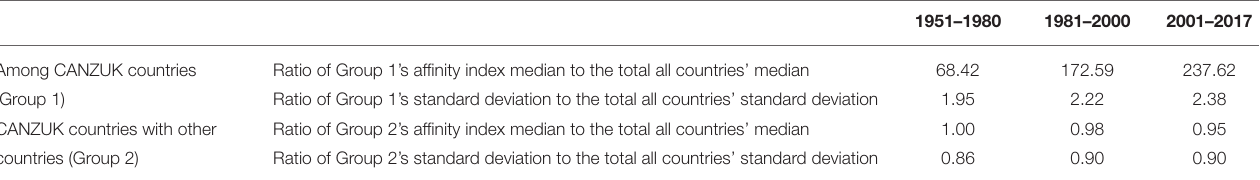
TABLE 3 | Comparing the ratios of medians and standard deviations of affinity index values of each group to the values of the total all countries, using the whole counting method.